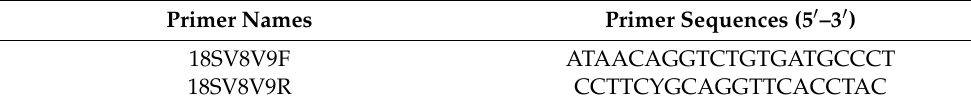
Table 1. PCR primers used in gene cloning and expression.